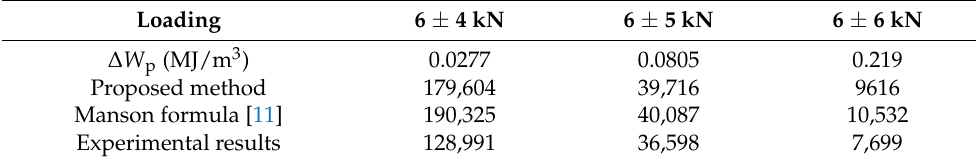
Table 9. Estimated and experimental results of the fatigue life of